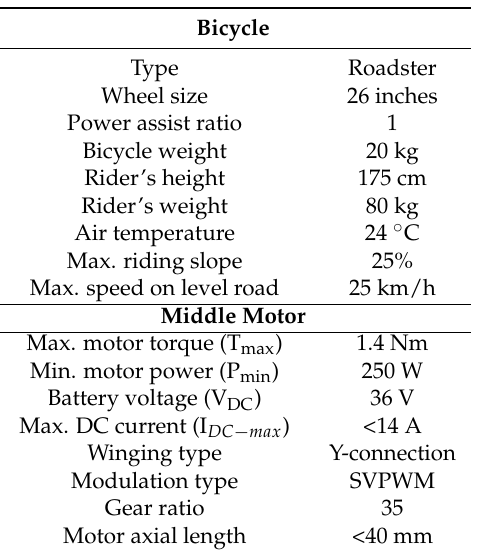
Table 1. Driving requirements and